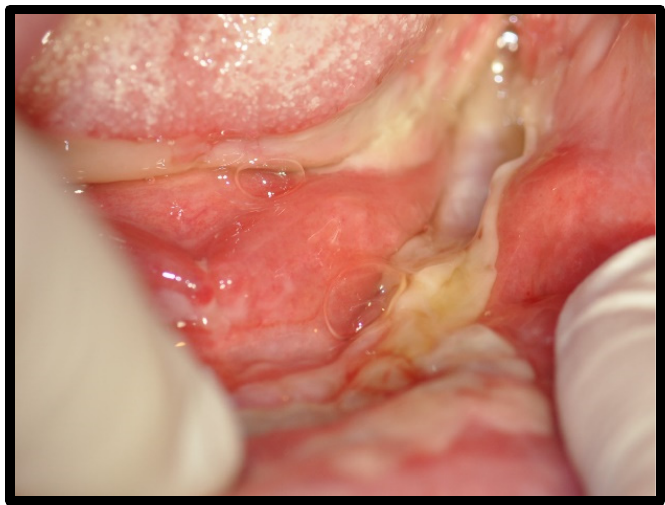
Figure 3. Exacerbation of oral lichen planus; the biopsy was documented years before the cancer diagnosis. The patient, on pembrolizumab and switched to ipilimumab, presented with oral/gingi- val pain, bleeding, and the inability to perform oral hygiene.